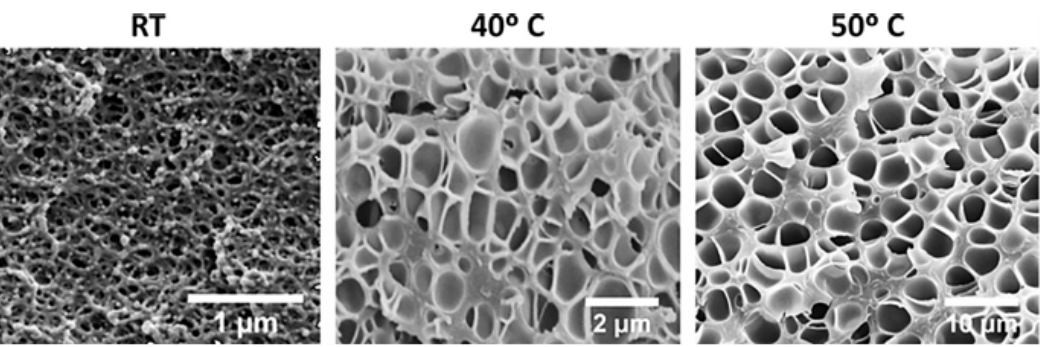
Figure 1. Cellular structure of PMMA foams produced after CO 2 saturation (30 MPa) at room temperature (RT), 40 °C, and 70 °C [46]. Reproduced with permission from Elsevier.